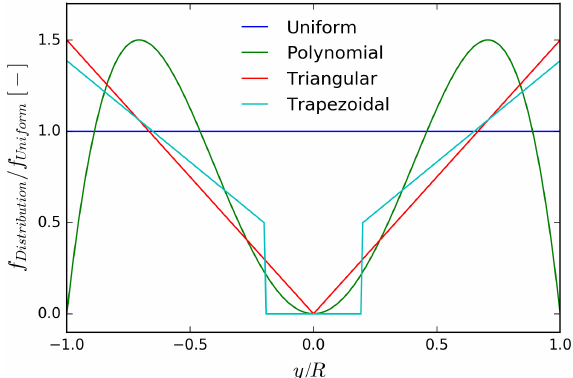
Figure 2. Normalized plot of all four distributions along a diameter of the